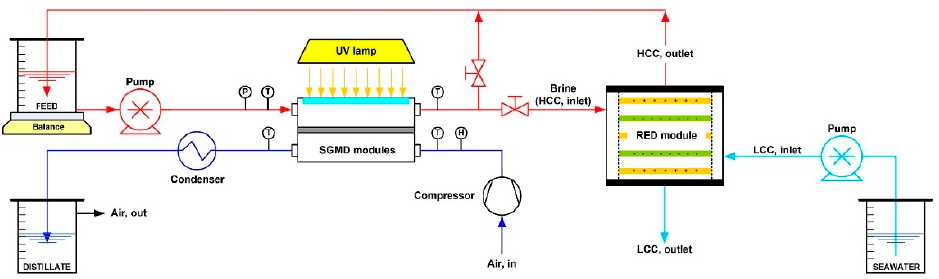
Figure 18. Scheme of the lab-scale photothermal SGMD-RED setup. Reprinted from [114] Copyright (2020) with permission